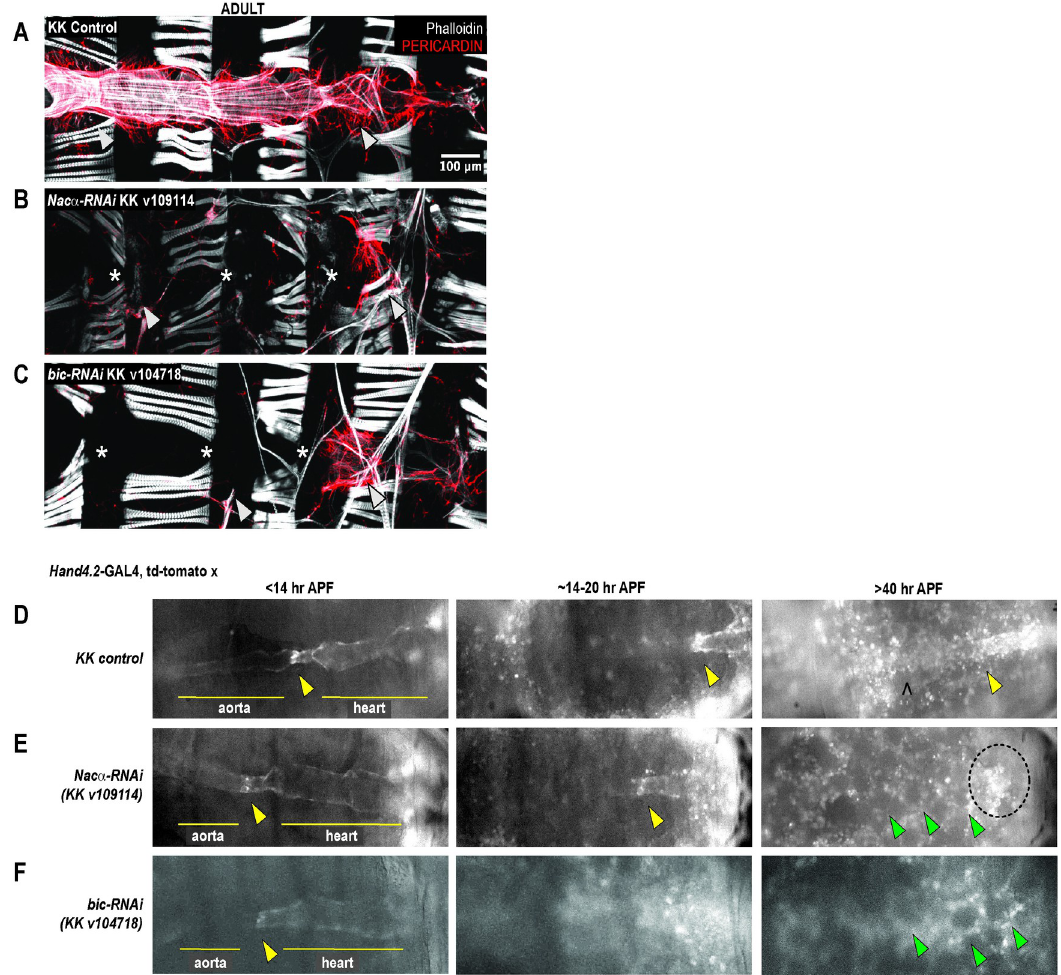
Fig 1. Knockdown (KD) of either subunit of Nascent polypeptide Associated Complex led to complete histolysis of the heart in adult flies. Hand4 . 2 -GAL4 driving heart specific expression of A, KK control B, Nac α - RNAi (KK v109114) or C, bicaudal -RNAi (KK v104718). KD of Nac α or bicaudal led to an absent heart in adult flies. � indicates absence of the heart tube. Arrowheads point to remnants of alary muscles that normally attach to the heart for structural support (anterior-left). Pericardin, a heart-specific collagen is largely absent, except for remnants in the posterior end. D, Representative still images from in vivo imaging movies (S1– S3 Videos) of remodeling pupal hearts from control, Nac α , and bicaudal KD flies . During the first hours of pupation, the internal valves (yellow arrowheads) are visible which separate the larval aorta (anterior) and the heart (posterior) which we use as a landmark through remodeling. At about 14-20hr APF, these internal valves are present but the aorta is more difficult to visualize as the heart transdifferentiates. After 40hr APF, the remodeling adult heart tube is visible in controls with identifiable ostia structures (marked by a ^). In Nac α and bicaudal KD hearts, no heart tube is visible and the area is filled in by rounded fat cells (green arrowheads). The area of the embryo with fluorescent signal (circled) are remnants of histolyzed cardiomyocytes that slowly disperse and weaken in intensity. APFs are approximate due to developmental delays caused by reduced ambient temperatures in the microscope